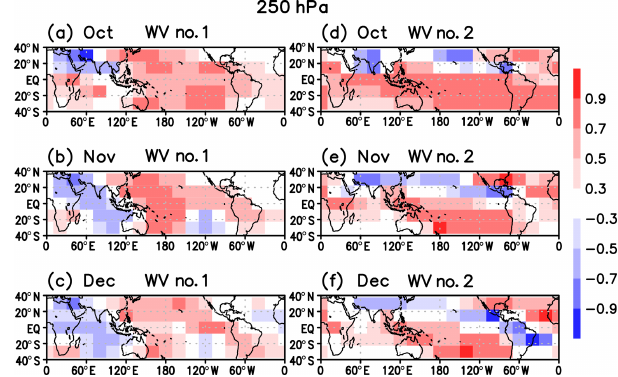
Figure 12. Correlation coefficients of spatial patterns between LBM-simulated eddy response to heating whose center is located at each grid and the climatological eddy height field north of 40 ◦ N at 250 hPa. Correlation value is plotted at the center of the heating location. (a–c) Wave-1 field from October to December. (d–f) Same as panels (a–c) but for the wave-2 field.